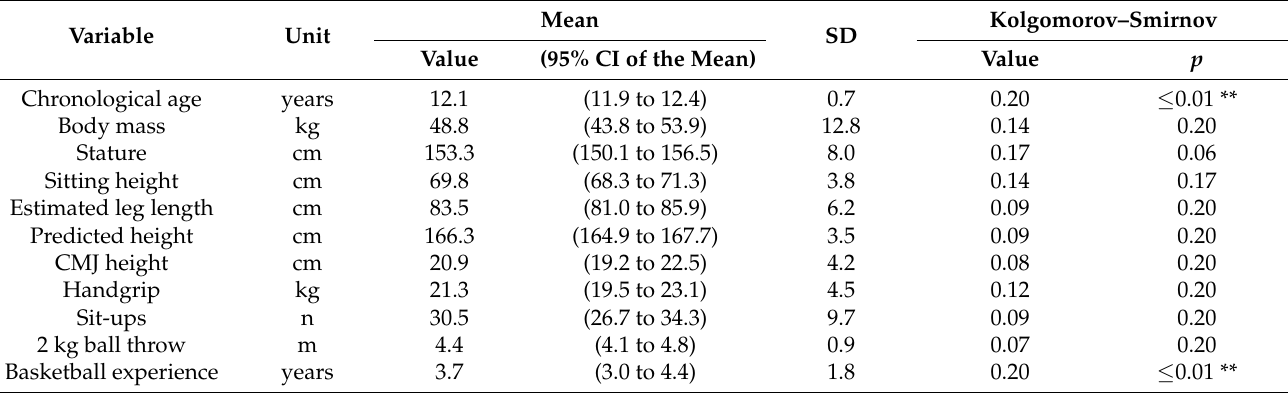
Table 1. Descriptive statistics on anthropometry, biological maturation, and fitness tests of female adolescent basketball players (n = 27).